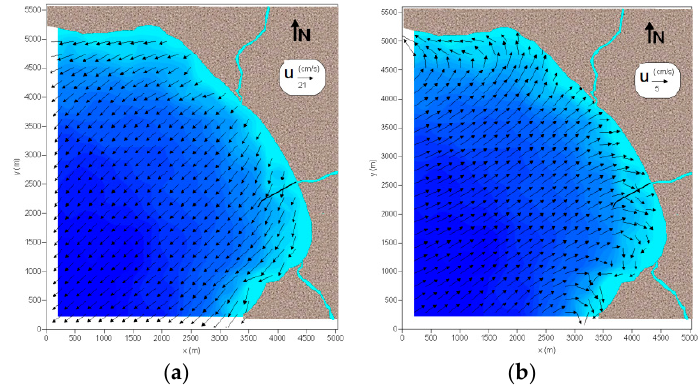
Figure 10. Current pattern: ( a ) sea surface layer and ( b ) bottom layer, for wind blowing from NE with speed 10 m/s at the steady state [33]. Table 2. Wind velocities and occurrence frequency